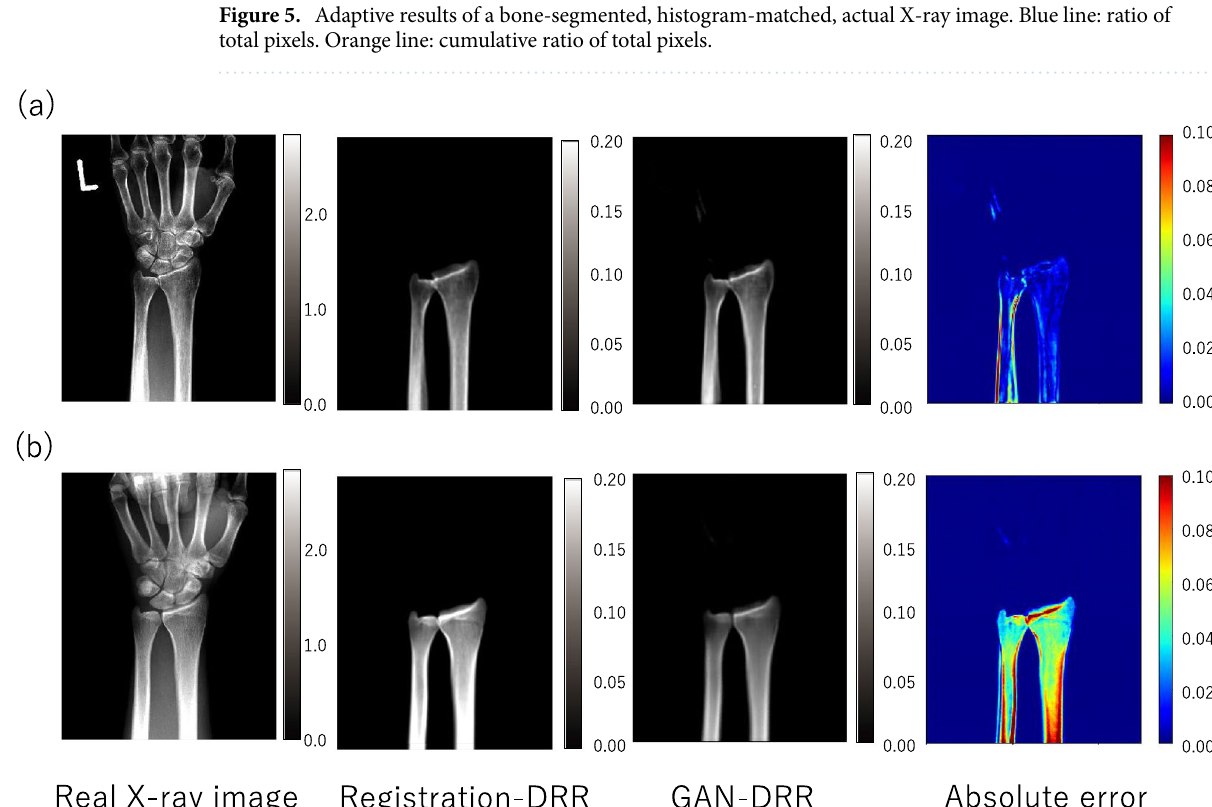
Figure 6. Mean absolute error (MAE) of image translation for each